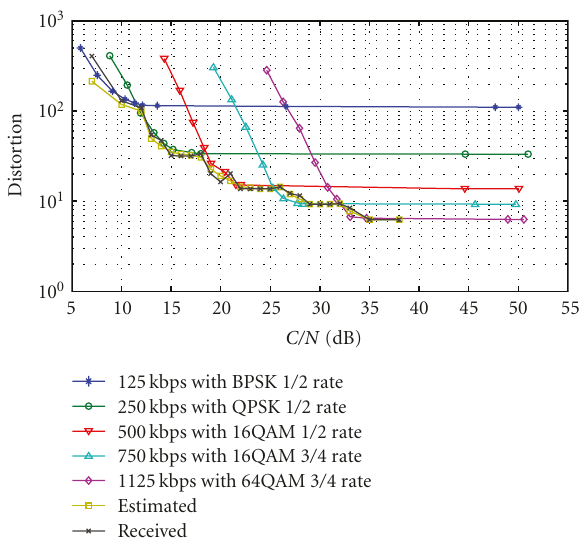
Figure 21: Distortion comparison, foreman , GOP number 8, initial mode = 3, Set (a).